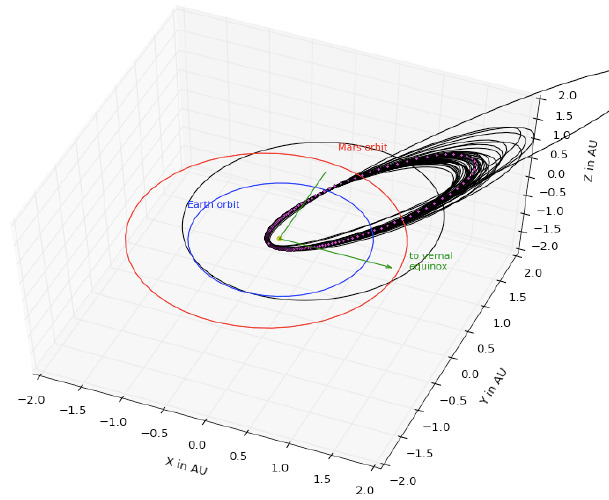
Figure 9: 3-D view of the orbits of meteors associated with the Geminid Fig. 9. 3-D view of the orbits of meteors associated with the Gemi- meteor shower by MetRec in the nights 13-15 Dec 2011. nid meteor shower by MetRec in the nights 13–15 December 2011.